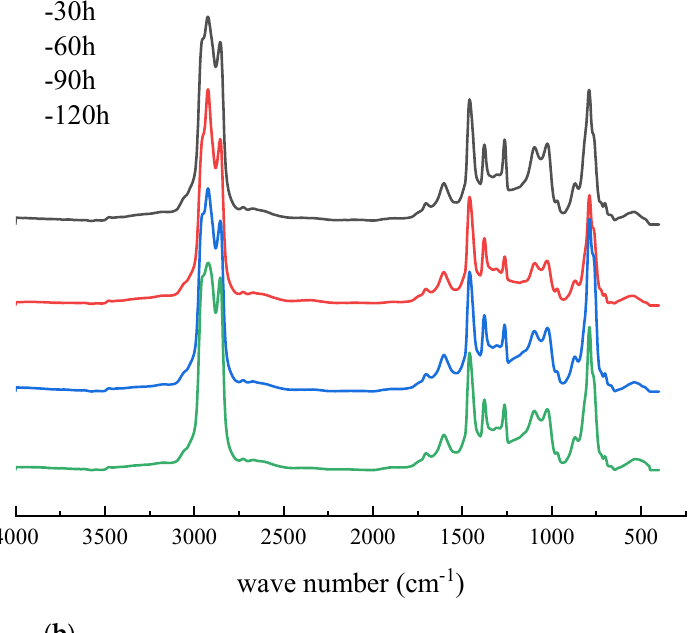
Figure 5. Infrared spectrum of asphalt binders after UV aging. ( a ) SBS-modified asphalt binder; ( b ) SBS + 1% CNTs composite-modified asphalt binder.